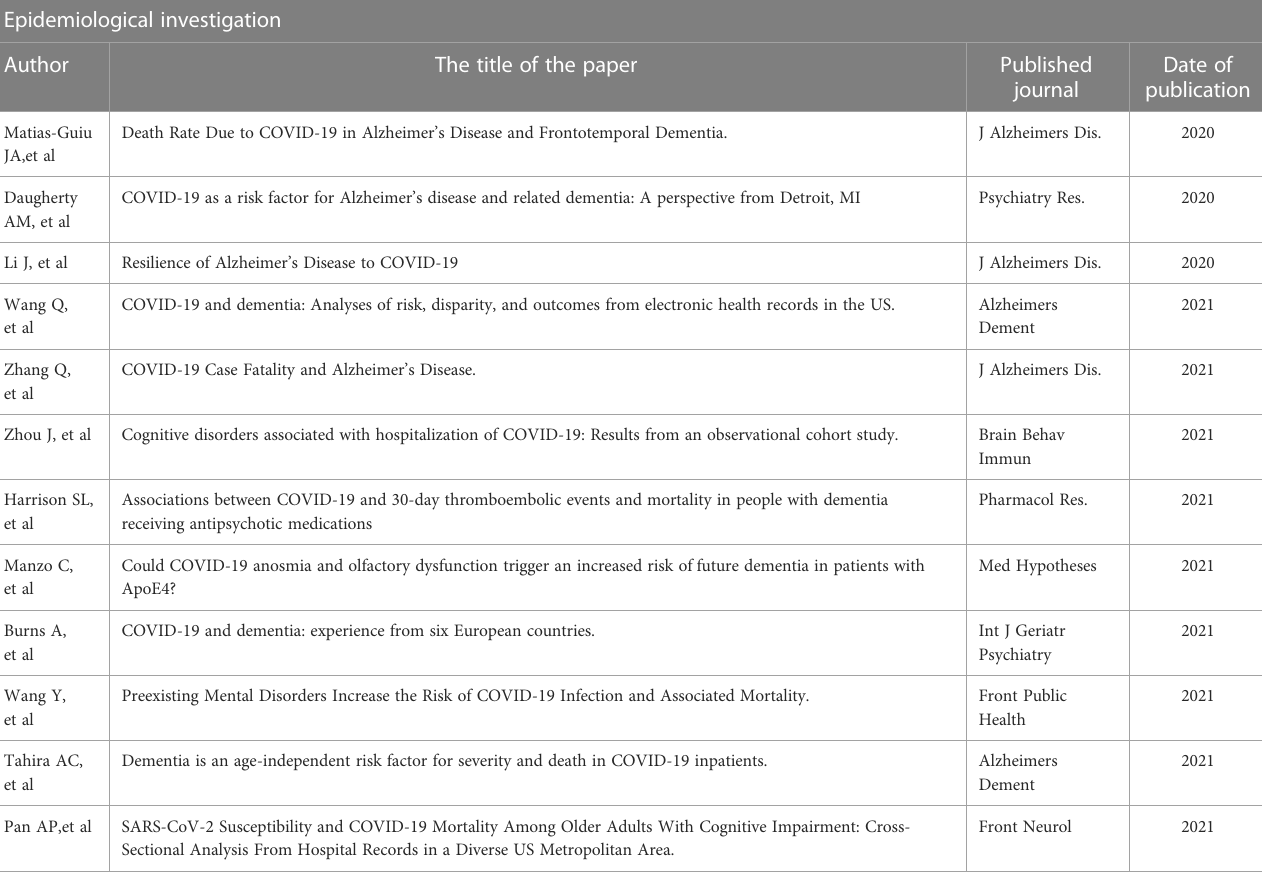
TABLE 1 The past studies on Alzheimer ’ s disease and COVID-19 infection and mortality rate or disease progression and other major fi ndings. Epidemiological